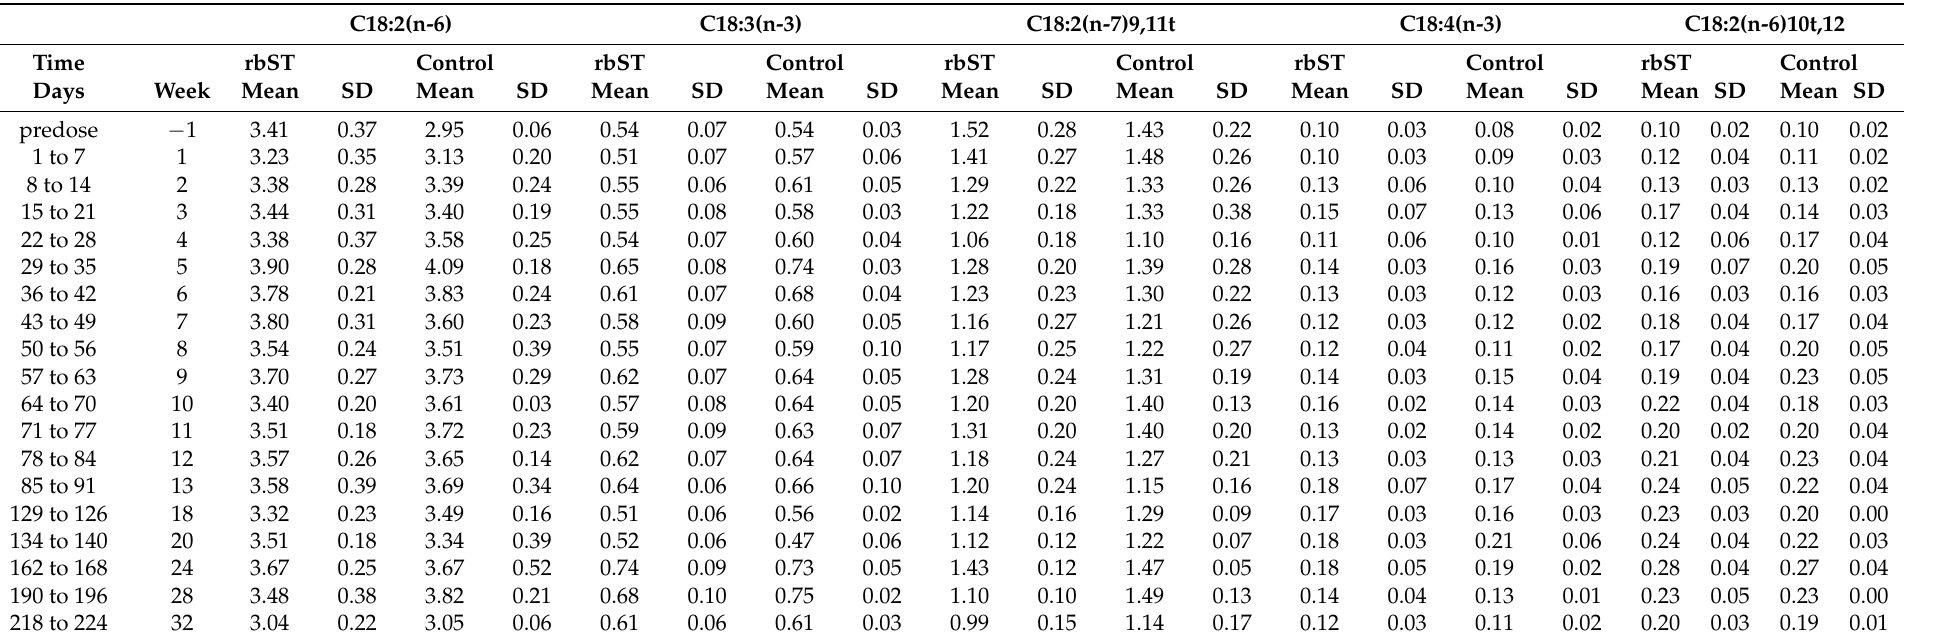
Table 6. Polyunsaturated fatty acids with 18 carbons in milk (% w / w of total fatty acids) obtained from cows treated with recombinant bovine somatotropin (rbST) ( n = 6) and from control animals ( n = 3) at different time points selected over the course of 37 weeks (8 injections of Lactotropina manufactured by Elanco, Eli Lilly,